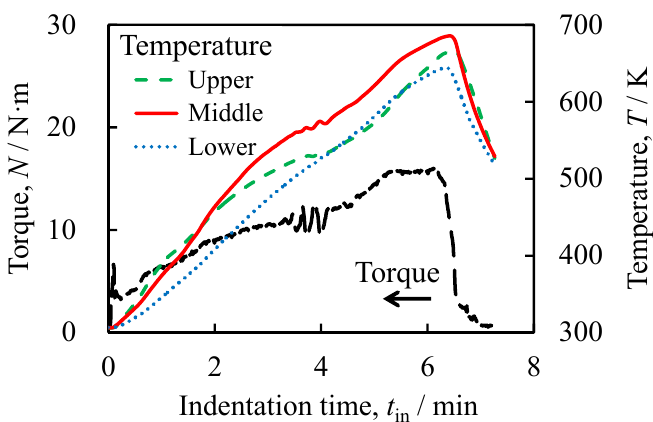
Figure 2. Torque of the rotating tool N and jig temperature T as functions of indentation time t in during friction welding. The temperature was observed at upper, middle, and lower positions in the jig as shown in Figure 1.